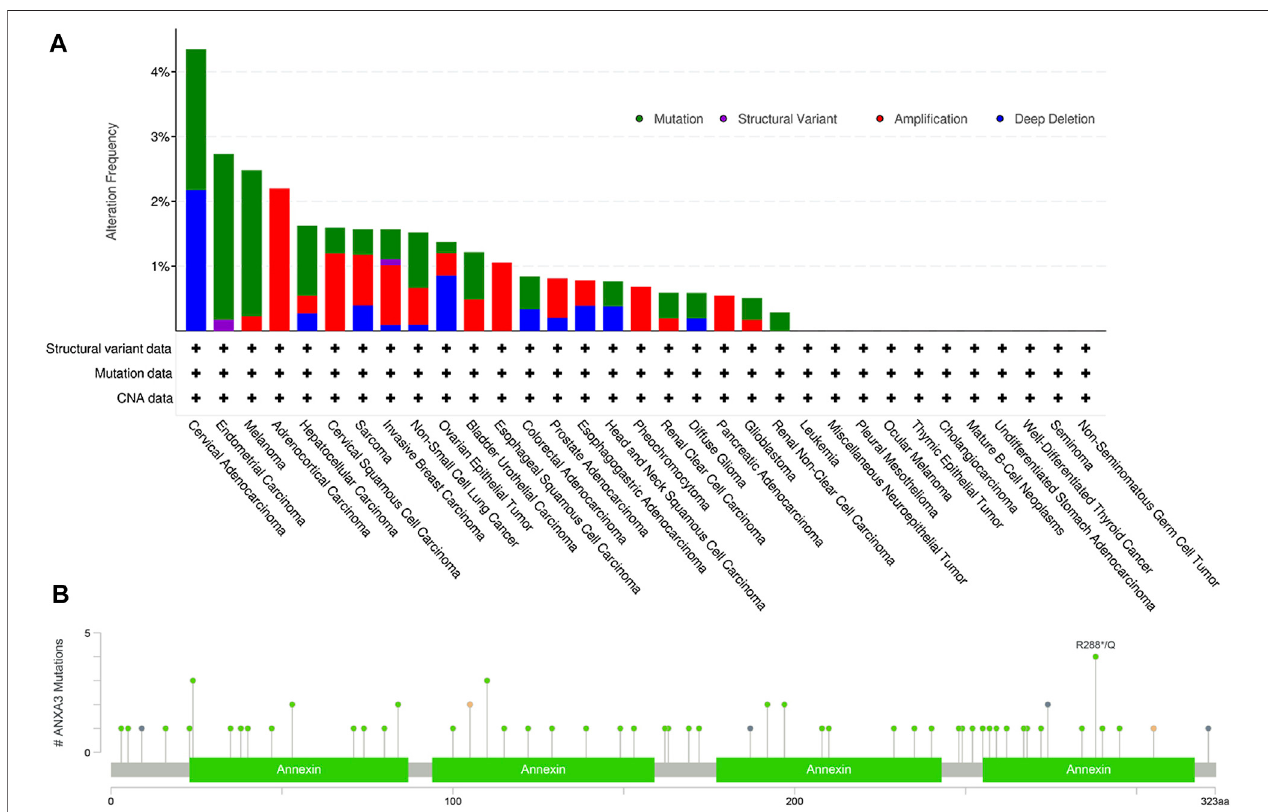
FIGURE 3 | Genetic alterations of the ANXA3 gene. (A) The alteration frequency of the ANXA3 gene in different cancer types. Y-axis represented the alteration frequency, and X-axis showed the cancer types with descending alteration frequencies. The colors used in the histogram represented different types of genetic alterations, which were shown with the top right legend. (B) The type, location and number of mutations occurred on the ANXA3 gene. Y-axis showed the number of ANXA3 mutations and the X-axis represented the amino acid sequence. Green, black, orange, and violet dots represented missense mutations, truncating mutations, splice-site mutations, and gene fusions respectively. Data has been retrieved from cBioPortal (http://www.cbioportal.org, June 2021).